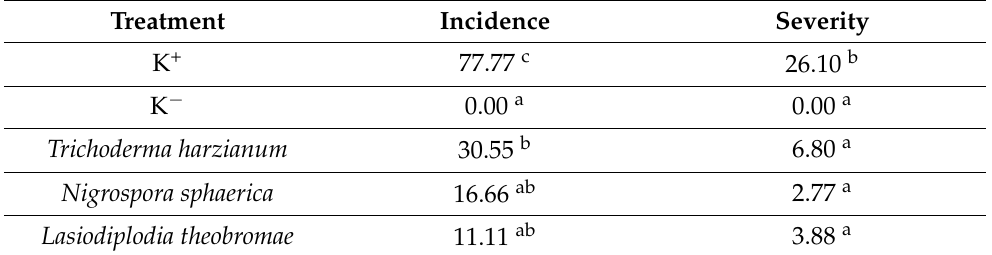
Table 5. Incidence and Severity of Fusarium Wilt on Banana Rhizome Eight Weeks after Inoculation